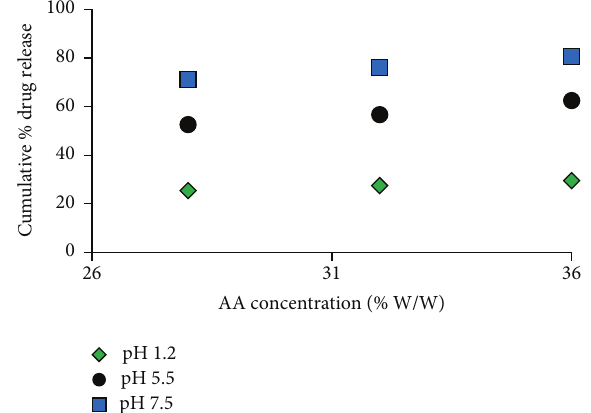
Figure 7: Cumulative % release of pheniramine maleate from AA/Gelatin hydrogels after 12h using different concentrations of acrylic acid (28.0, 32.0, and 36.0 g) and EGDMA as cross-linking agent (0.7% of AA) at various pH values in 0.05 M USP phosphate buffer solutions.